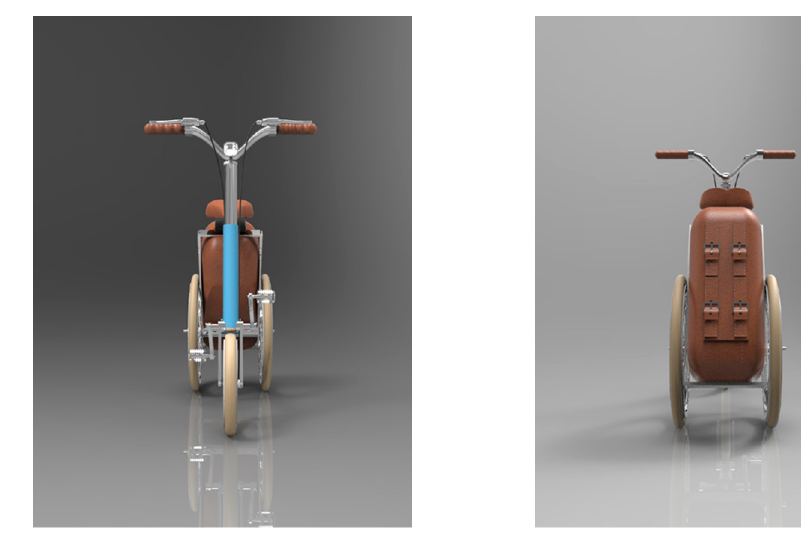
Figure 17. 3D model and rendering.